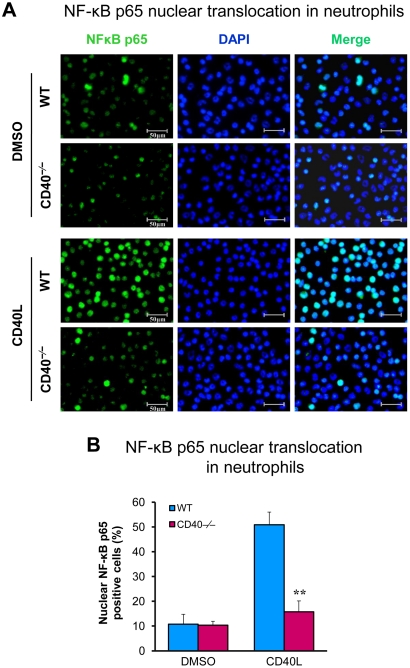
CD40 is required for CD40L-induced activation of NF-κB pathway in neutrophils.(A) NF-κB nuclear translocation was assessed by immunofluorescence staining for NF-κB p65 (green) in wildtype and CD40-deficient neutrophils exposed to CD40L (1.0 µg/ml) for 1 h. Cell nuclei were detected by DAPI (blue). Scale bars: 50 µm. (B) NF-κB nuclear translocation was assessed and quantified as the percentage of the p65 nuclei-positively stained cells to the total cells. Similar results are obtained from three independent experiments. Data are expressed as mean ± SEM. **
P<0.01 versus WT.